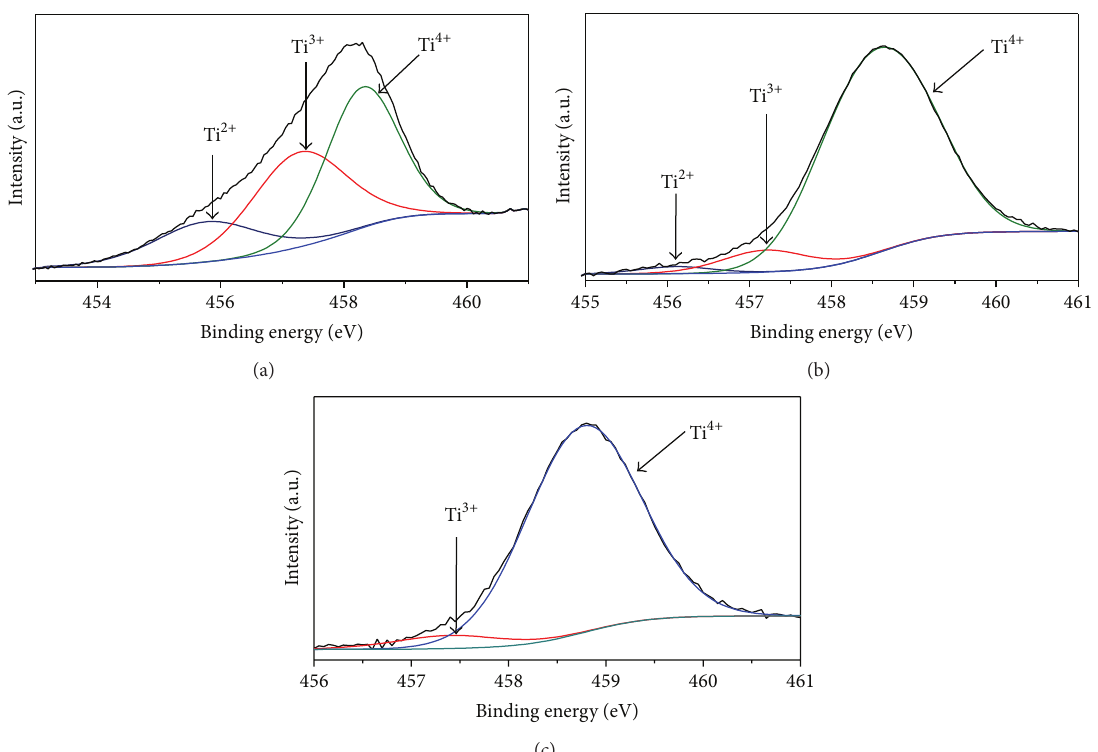
Figure 1: XPS spectra for Ti2p 3/2 core level of the films deposited at (a) 0.2, (b) 0.6, and (c) 3.5 sccm.